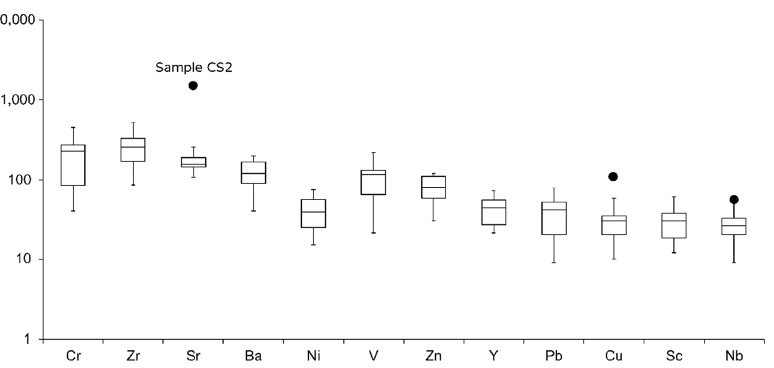
Figure 7. Box plot showing trace element (ppm) compositions of Vitulano bauxites. Black circles indicate outliers. Total REEs concentration ( Ʃ REEs) ranges from 141.74 ppm to 715.5 ppm with a me- dian of 356 ppm. The chondrite-normalised (Figure 8) (chondrite values are from Evensen et al. [34]) REEs pattern shows a moderate fractionation with (La/Yb) cho, which ranges from 9.65 to 13.80 with median values of 10.64. REEs normalised patterns show both positive and slightly negative Ce anomalies with Ce/Ce* median of = 0.98, while Eu exhibits only moderately negative anomalies with an Eu/Eu* median = of 0.71 ranging from 0.68 to 0.72.